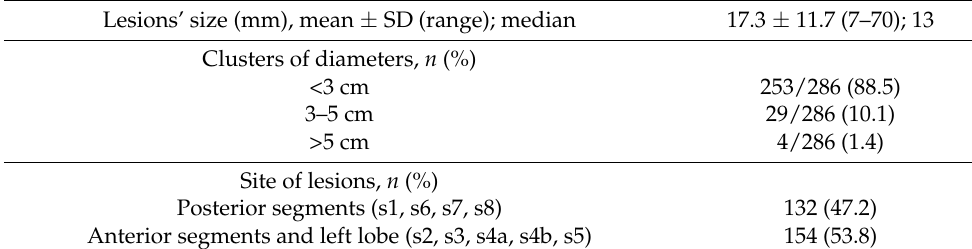
Table 3. Surgical and technical